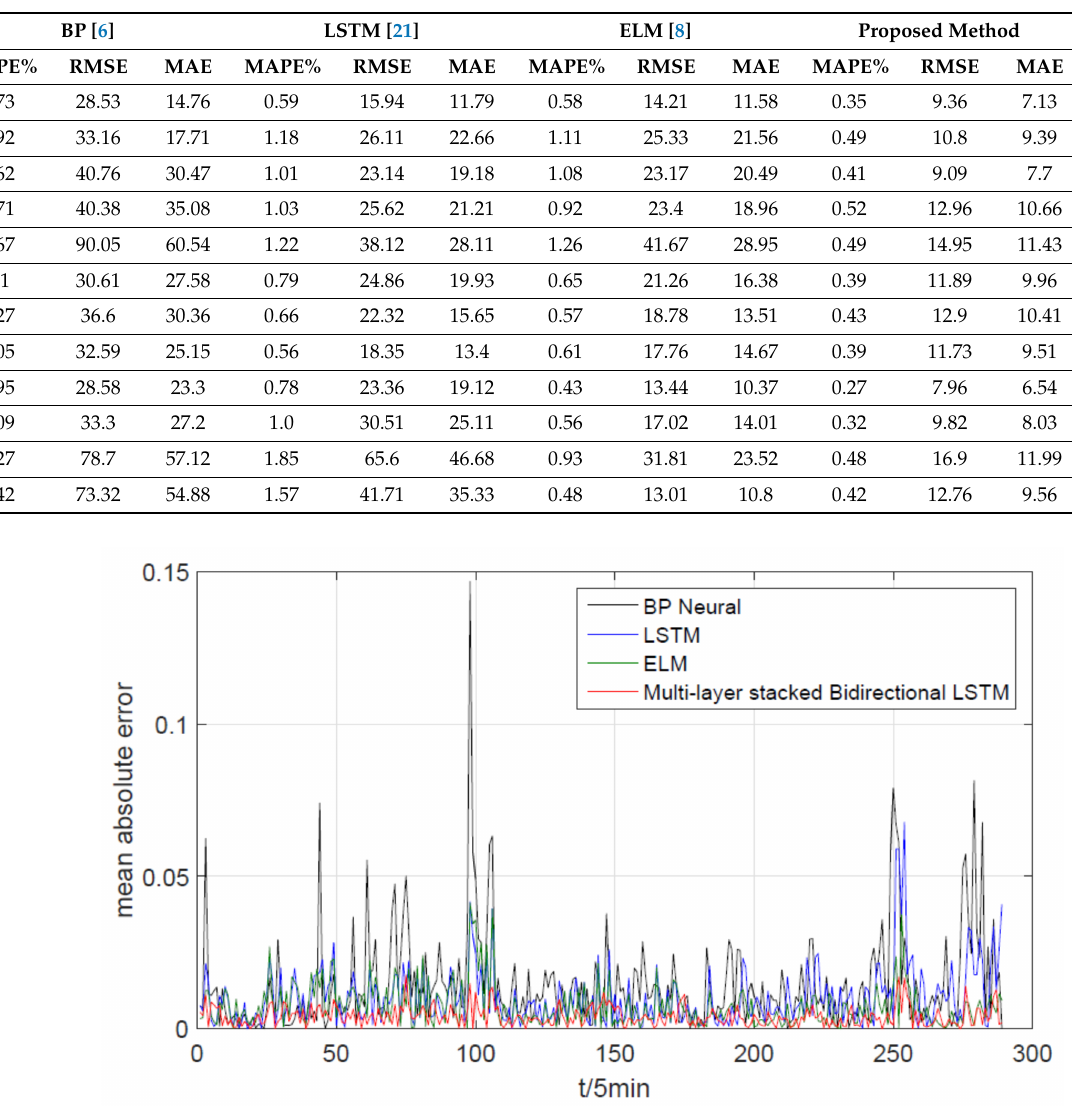
Table 4. Error comparison of different prediction models in a two-hour interval.